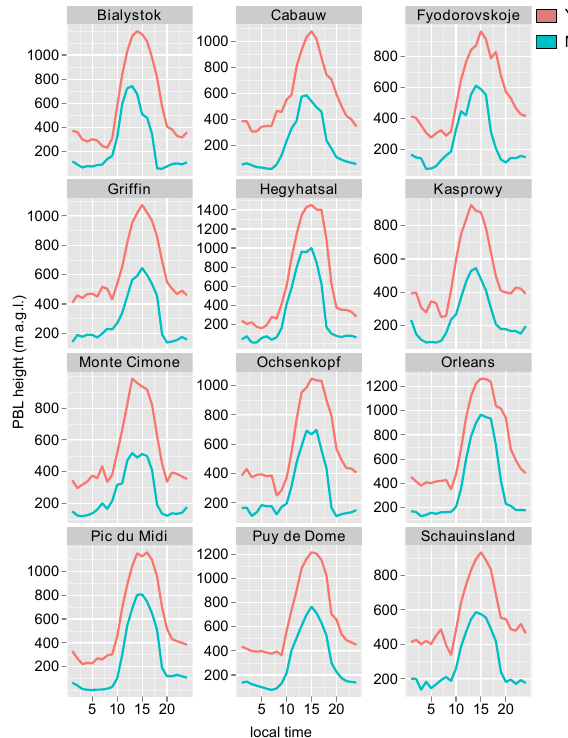
Fig. 7. Mean diurnal MH in m (a.g.l.) at grid cells containing the stations (from top to bottom, left to right): BIK, CBW, TVE, GRI, HUN, KAS, CMN, OXK, ORL, PDM, PUY and SCH. Results from the YSU and MYJ simulations are shown in red lines and cyan lines